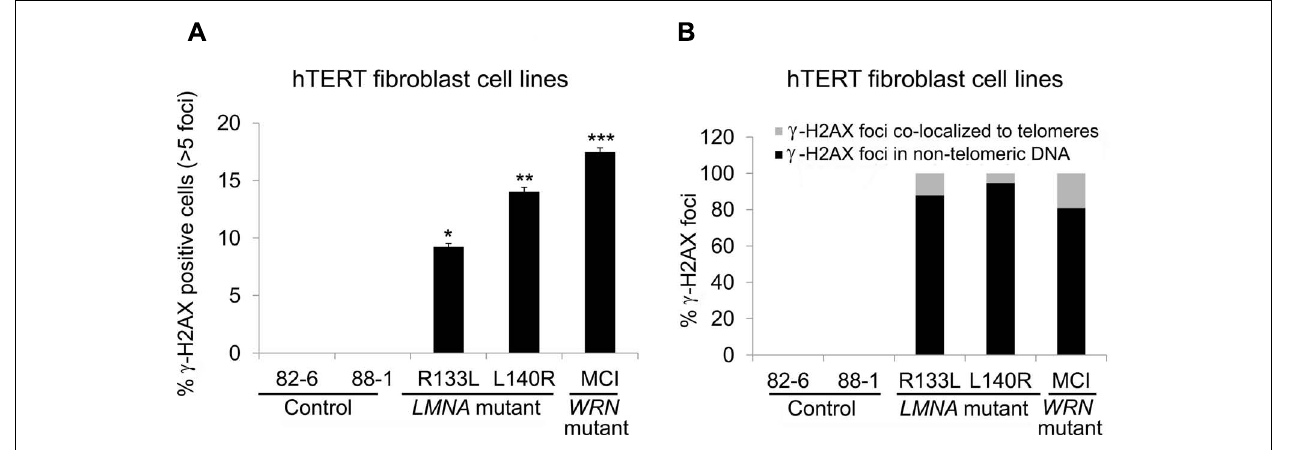
FIGURE 5 | Detection of γ -H2AX foci in control and LMNA mutant fibroblasts expressing hTERT. (A) Percentage of cells with > 5 γ -H2AX- labeled foci, as stated in Figure 3 . * P < 0.05, ** P < 0.005, *** P < 0.001.